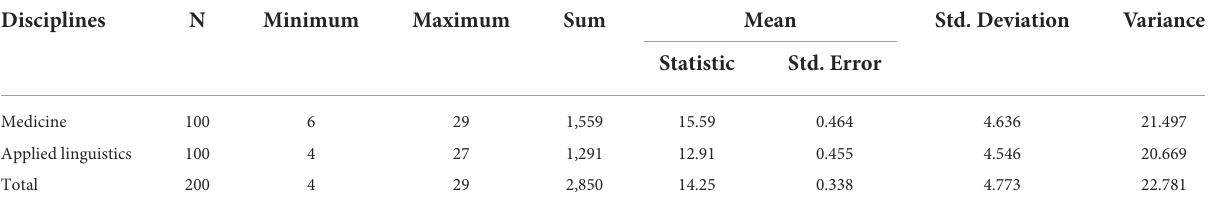
TABLE 1 Descriptive of title length across disciplines.